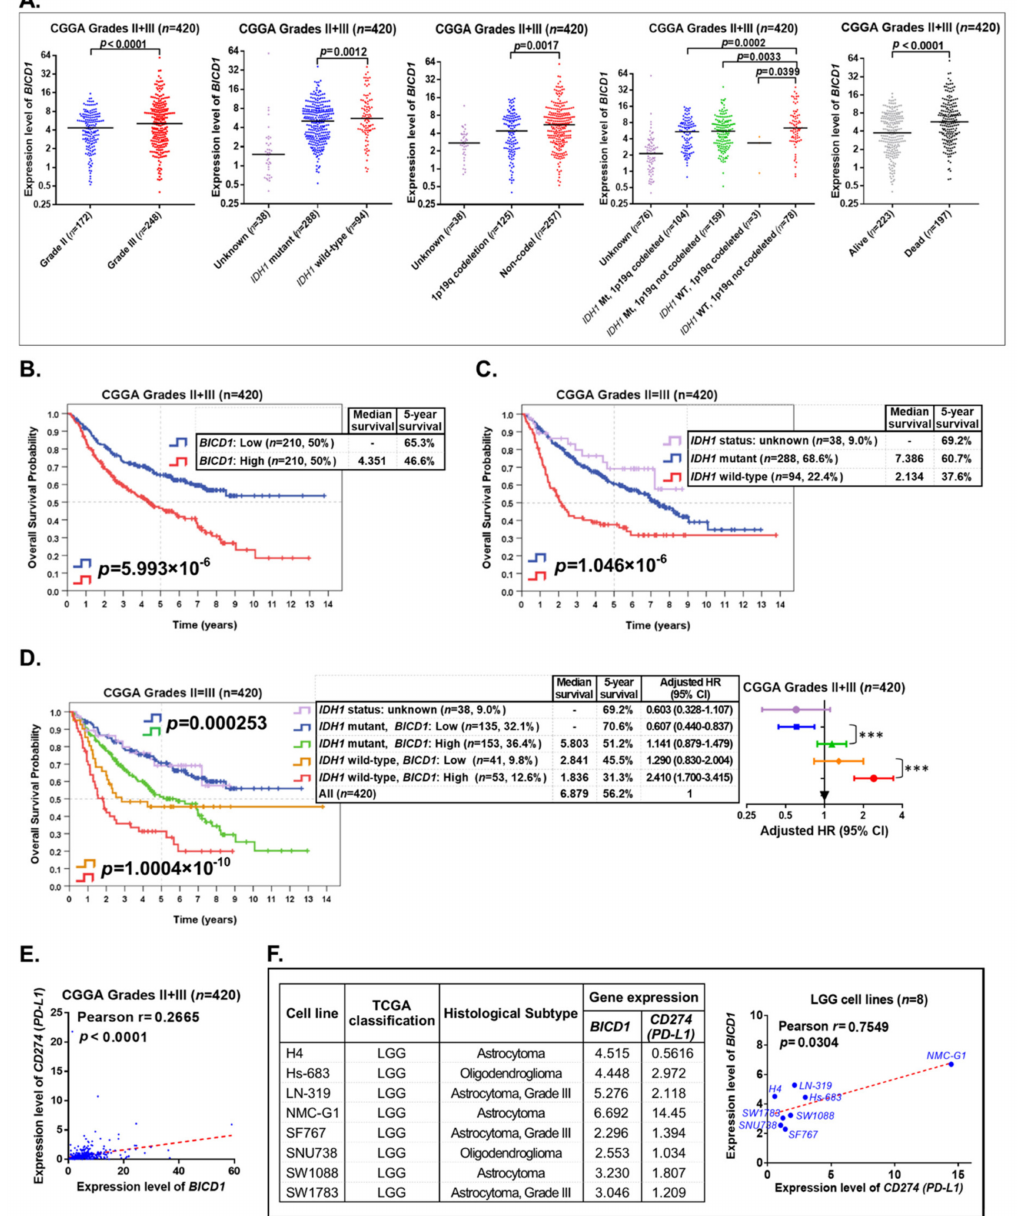
Figure 7. Validating the prognostic role and significance of BICD1 downregulation and its correlations with the clinicopatho- logical features in other LGG datasets. ( A ). The t -test analyses revealed the correlations of BICD1 expression with the WHO grade, IDH1 status, 1p19q codeleted status, and survival status in LGGs in the CGGA dataset. The differential expression of BICD1 in LGG subgroups stratified by their IDH1 status and 1p19q codeleted status is also shown. ( B ). The Kaplan–Meier survival analyses revealed the prognostic role and significance of BICD1 downregulation in LGGs in the CGGA dataset. ( C ). The prognostic role and significance of IDH1 status in LGGs in the CGGA dataset. ( D ). The improvement in prognostic accuracy when BICD1 expression was incorporated with IDH1 status to stratify LGG patients into four subgroups. The four LGG subgroups stratified by IDH1 status and BICD1 expression were ranked according to their HRs. The symbol “***” denotes statistical p < 0.001. ( E ). Pearson’s correlation analyses revealed the correlation between the expression level of BICD1 and that of CD274 (PD-L1) in LGGs in the CGGA dataset. ( F ). The expression levels of BICD1 and CD274 (PD-L1) in eight LGG cell lines in the CCLE dataset. Pearson’s correlation analysis revealed the correlation between the expression level of BICD1 and that of CD274